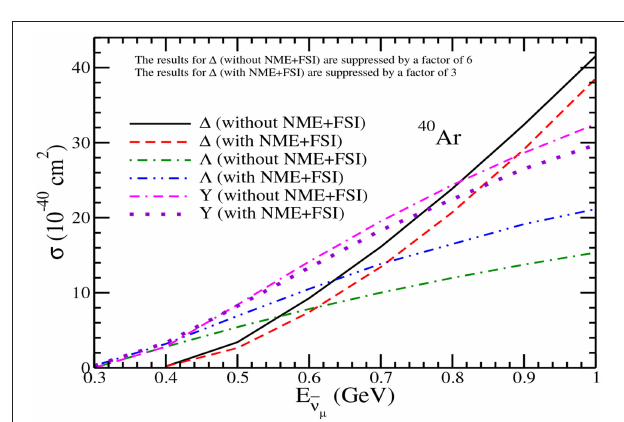
FIGURE 14 | Results for π − production in 40 Ar. Lines and points have the same meaning as in Figure 12 .